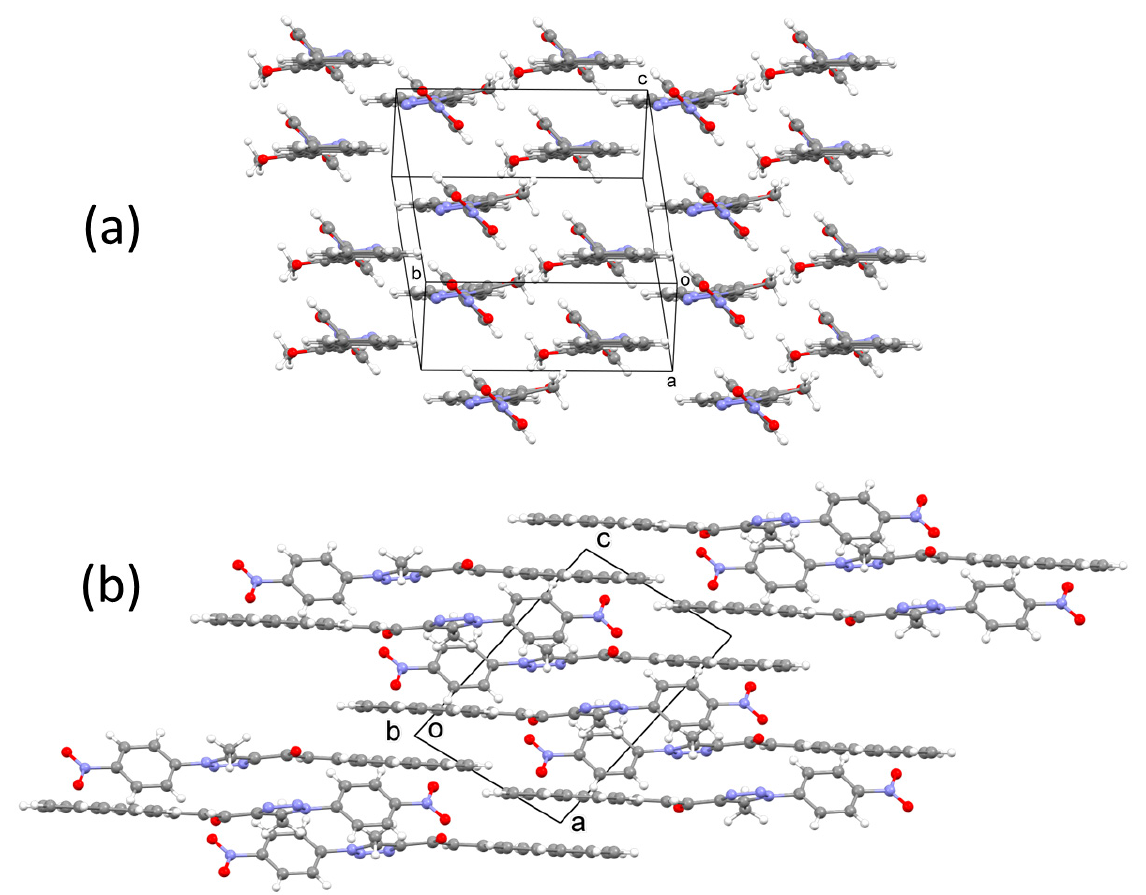
Figure 2. Views of the crystal structure ( a ) down the length of the molecule and ( b ) along the b axis.